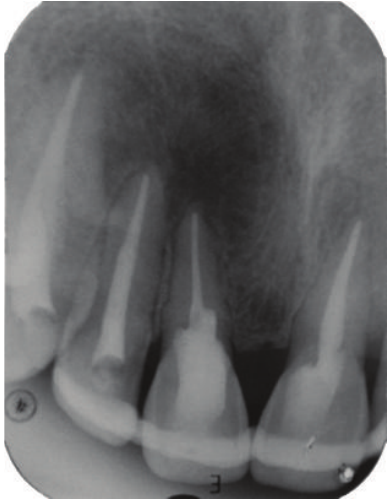
Figure 20: 6-month followup IOPA radiograph.